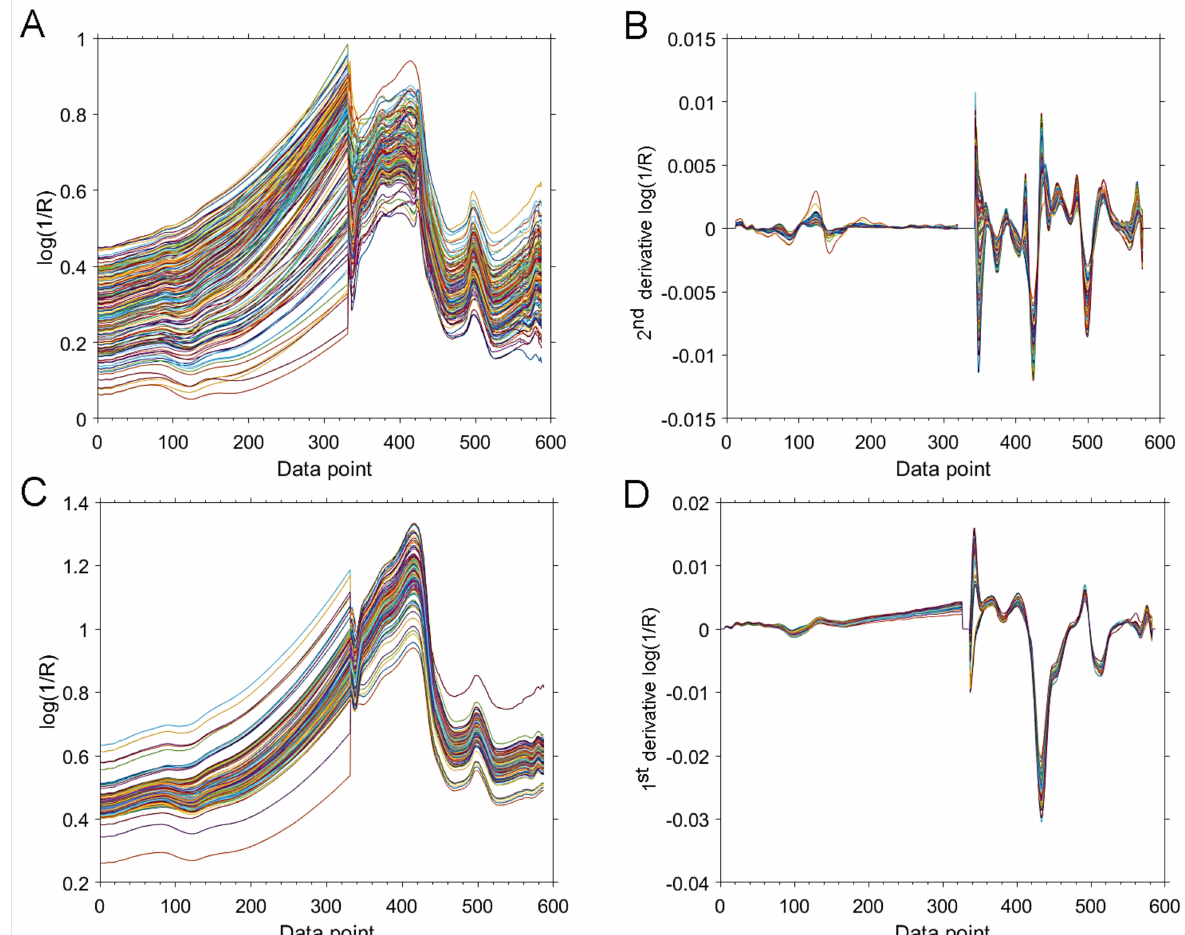
Figure 4. The fused spectra from the two cost-effective miniaturized NIR spectrometers (Tellspec Enterprise Sensor and SCiO Sensor) for intact ( A , B ) and milled ( C , D ) samples. A and C: unpretreated fused spectra. ( B , D ): fused spectra after pretreatments (SNV + SG2 with 25 SP and SG1 with 11